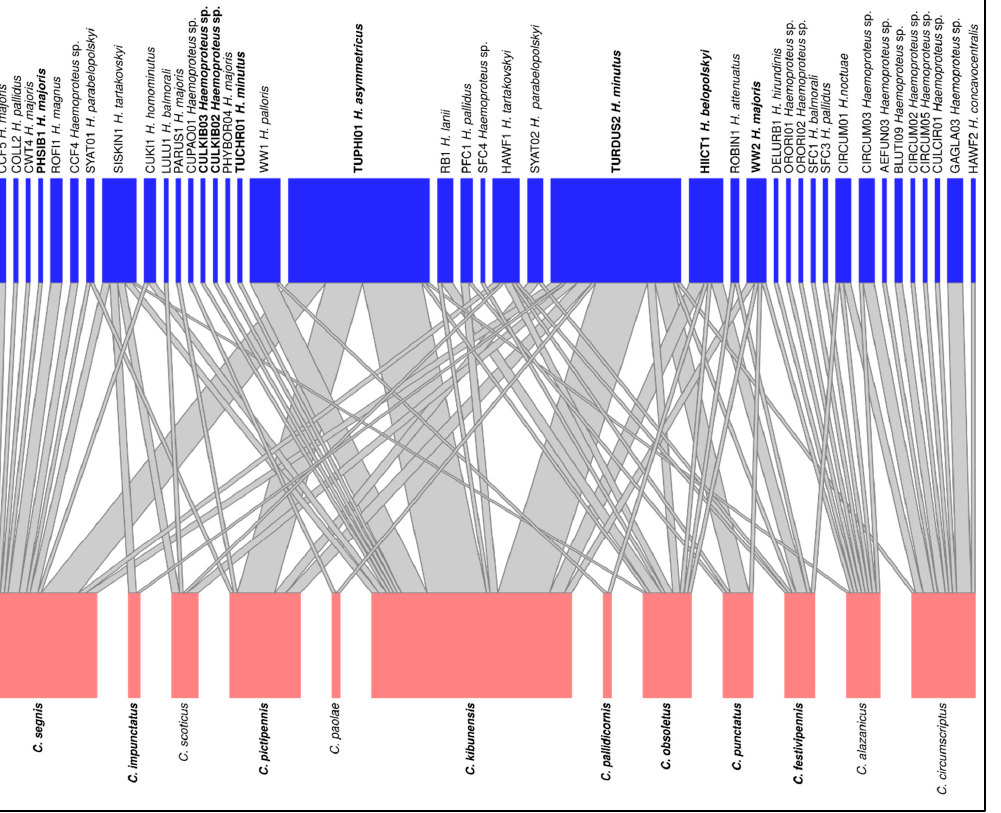
Figure 4. Bipartite interaction network between Haemoproteus cytb lineages (top, in blue boxes) and Culicoides species (bottom, in light red boxes). The width of the boxes is proportional to the frequency of the occurrence of a particular taxon. The width of connecting lines is proportional to the number of interactions observed between each Culicoides species and Haemoproteus lineage. Culicoides species and Haemoproteus lineages investigated and found in this study are marked in bold.